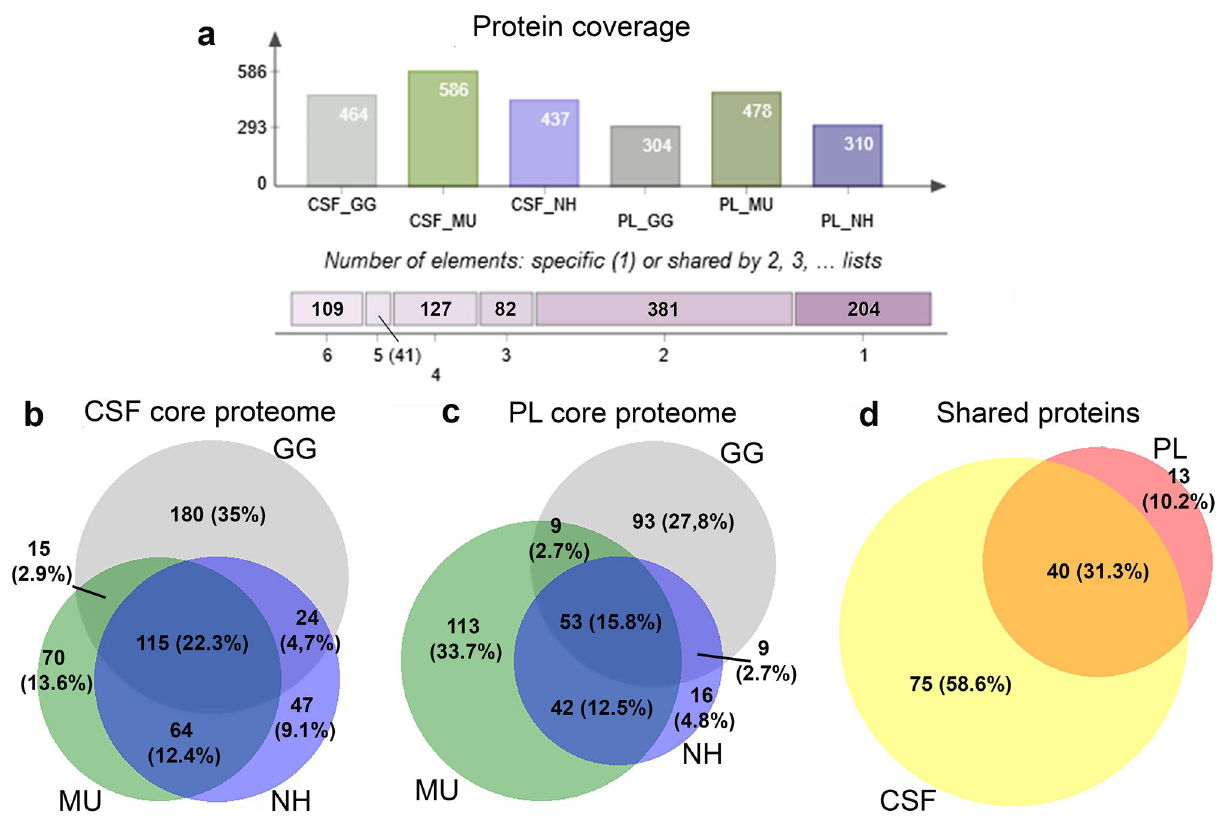
Figure 2. Overview of the proteomic coverage across species and body fluids. The identified plasma (PL) and cerebrospinal fluid (CSF) proteins of chicken (GG), budgerigar (MU) and cockatiel (NH) and the shared identifications between the groups are demonstrated in ( a ) (Venn Diagrams, http://bioin forma tics.psb.ugent .be/ webto ols/Venn/). The Venn diagrams are showing the overlapping numbers and percentages of core proteomes of CSF ( b ) and PL ( c ) for GG, MU and NH, and ( d ) the numbers and percentages of shared proteins across all the three species for CSF and PL (BioVenn, http://www.biove